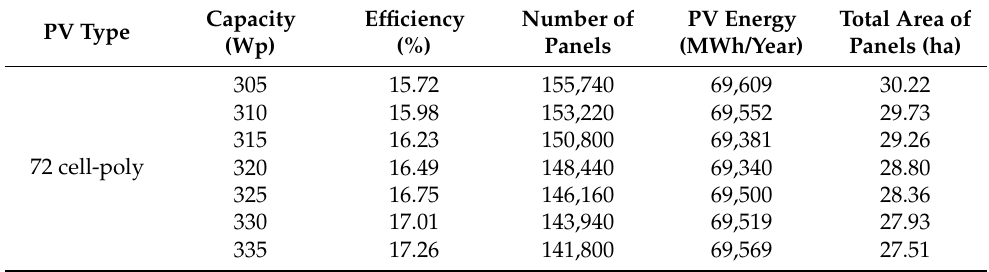
Table 3. Calculation results of different silicon panels.